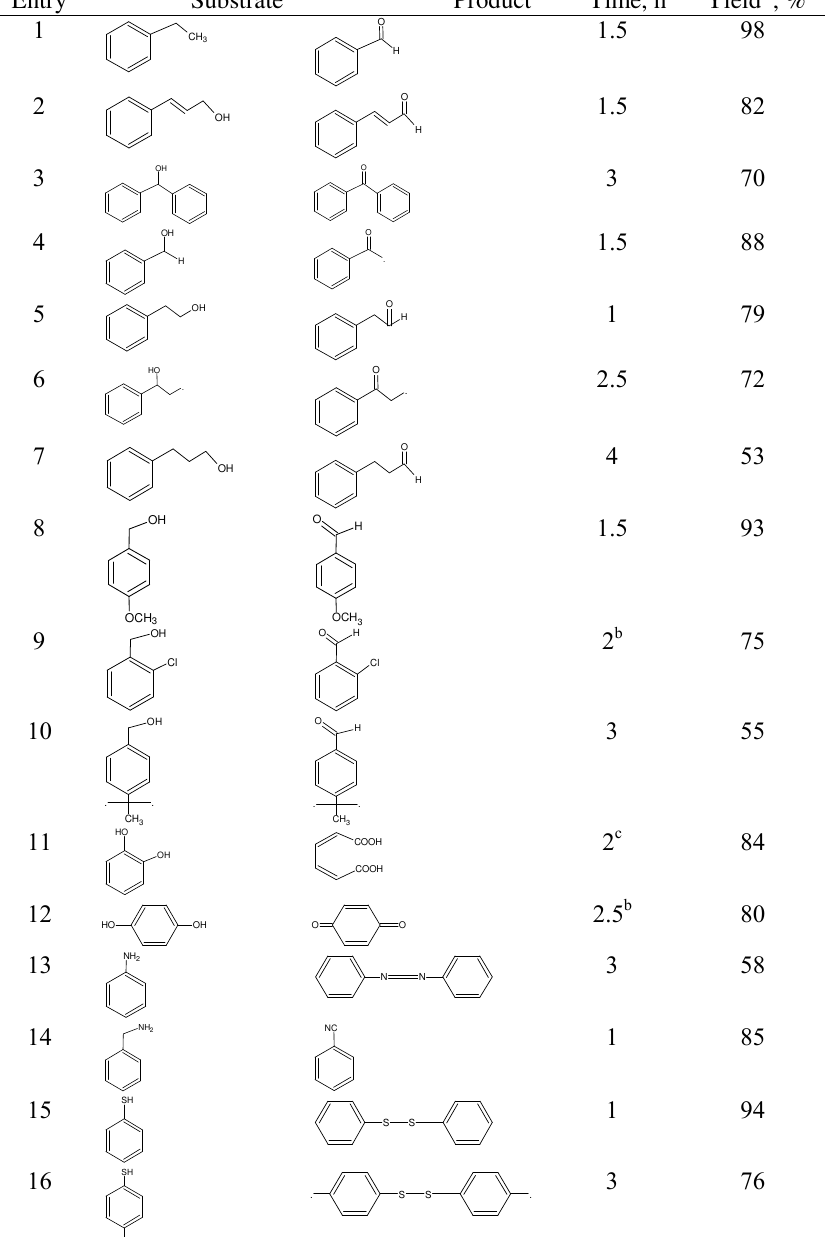
in n - hexane (unless otherwise 2